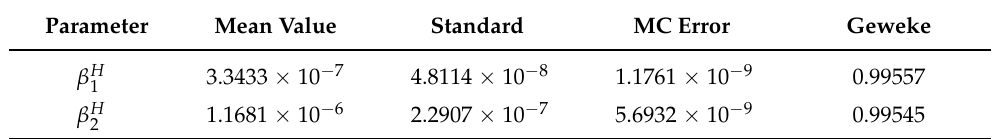
and β H with the method of 2 1